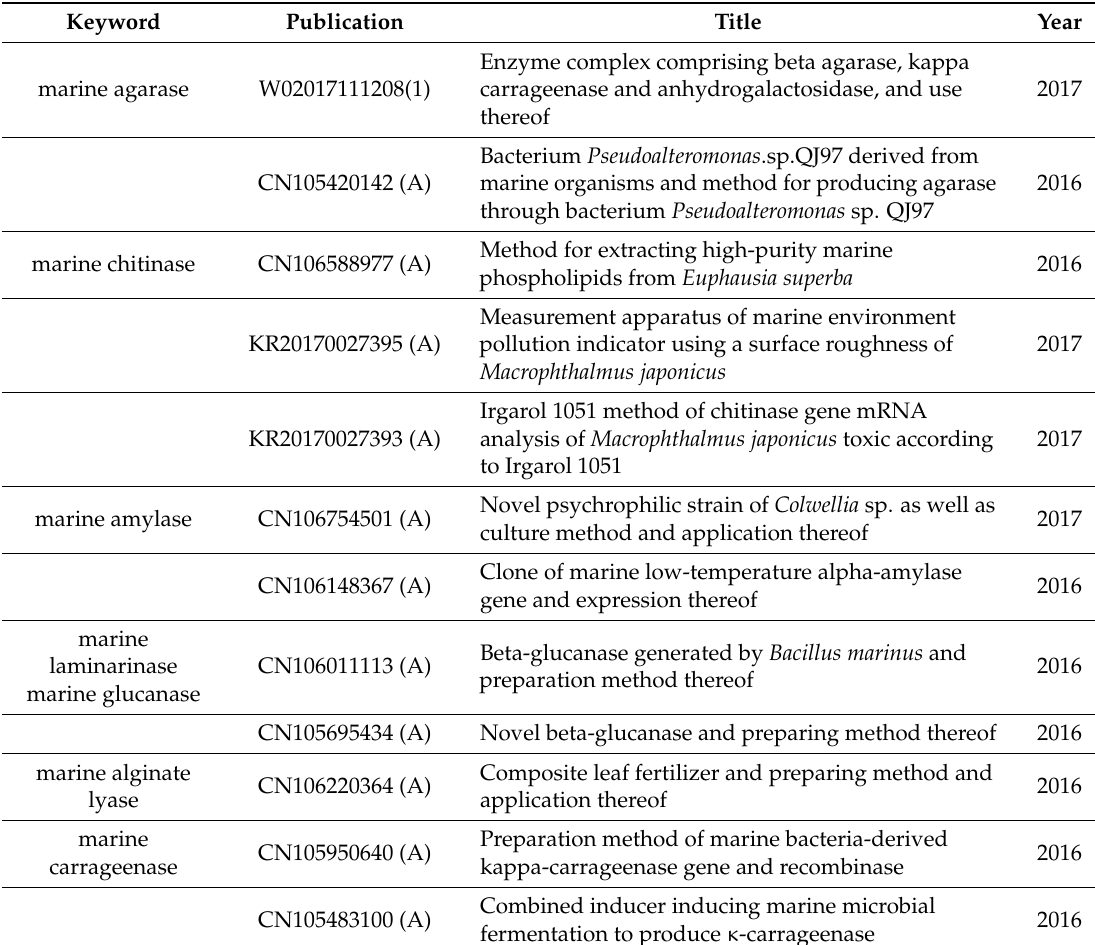
Table 1. Patents found for marine carbohydrate hydrolyzing enzymes for 2016–2017 interval time in Espacenet patent